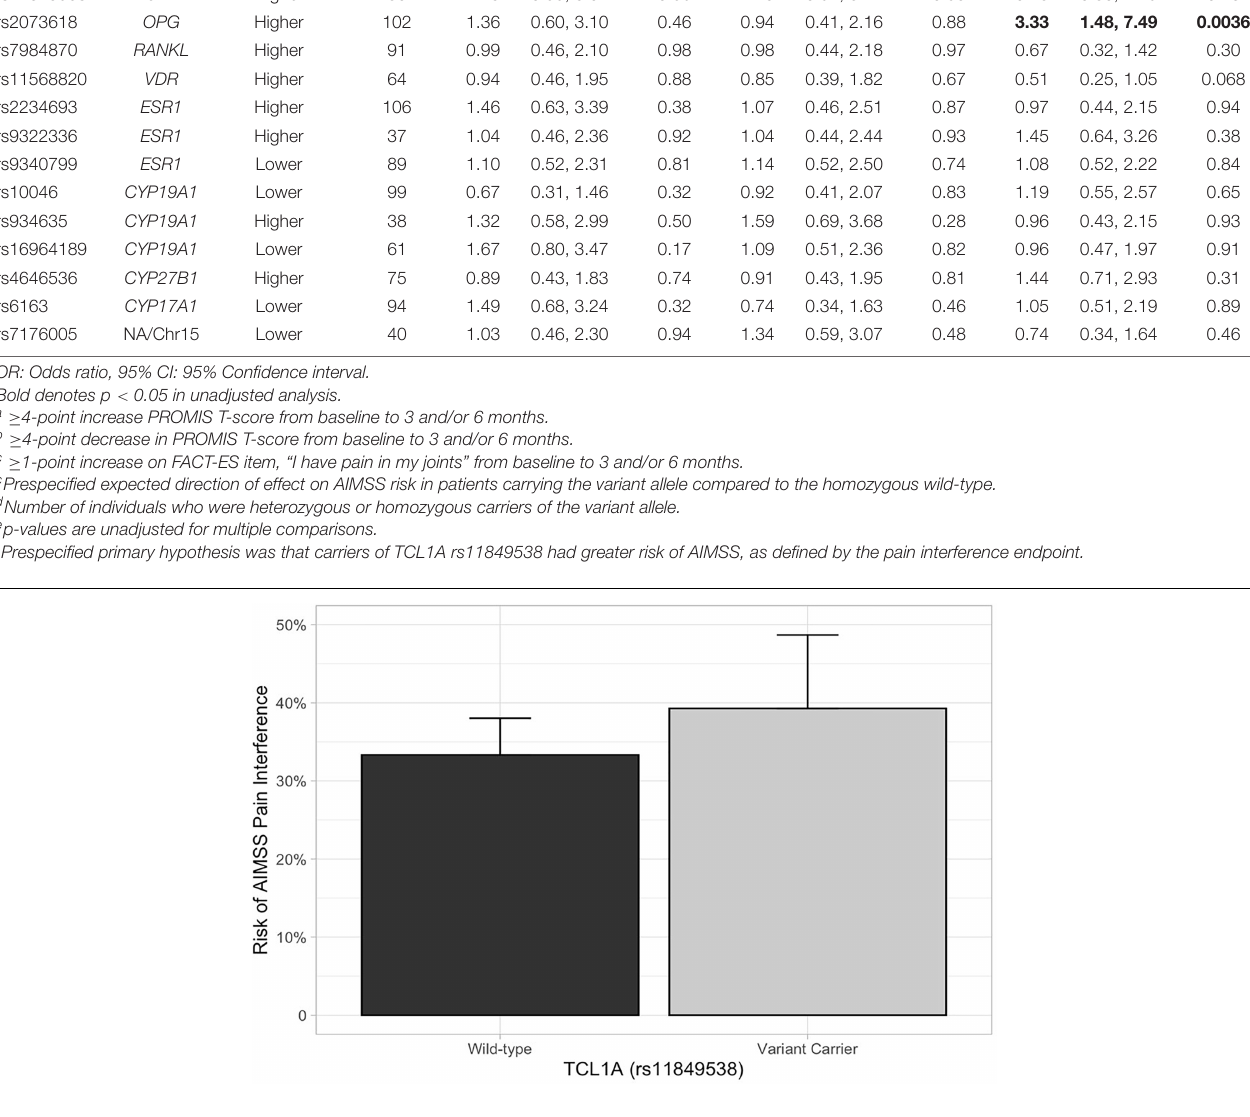
FIGURE 2 | AIMSS risk stratified by TCL1A rs11849538. The proportion of patients who experienced AIMSS ( Y -axis), as defined by a ≥ 4-point increase in PROMIS T-score from baseline to 3 or 6 months, is indicated by the box (standard error indicated by the vertical line). In the primary analysis, there was no increased AIMSS risk, as defined by an increase in the pain interference score from baseline to 3 or 6 months by at least four points, in patients carrying TCL1A rs11849538 ( n = 30, unadjusted odds ratio = 1.29, 95% confidence interval: 0.55–3.07, p = 0.56).